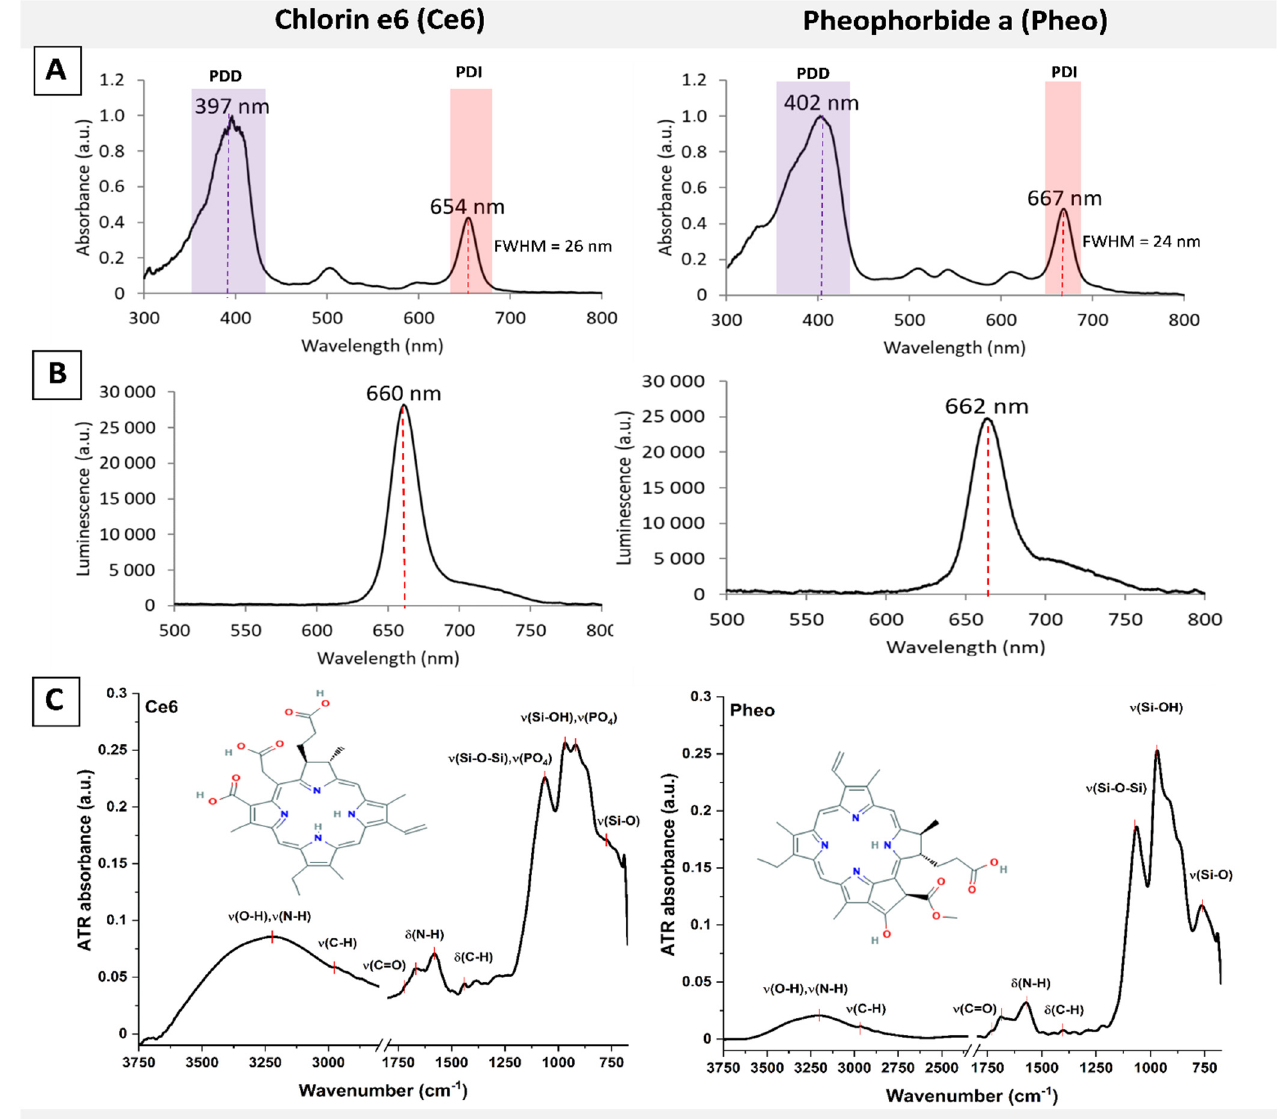
Figure 1. The characterization of the PS’s absorption ( A ) and luminescence spectra ( B ) for excitation at 405 nm with central wavelengths and full width at half maximum (FWHM) of spectral bands, and ( C ) attenuated total reflectance—Fourier transform infrared (ATR-FTIR) spectra of PSs in PBS buffer deposited on the silica glass surfaces.